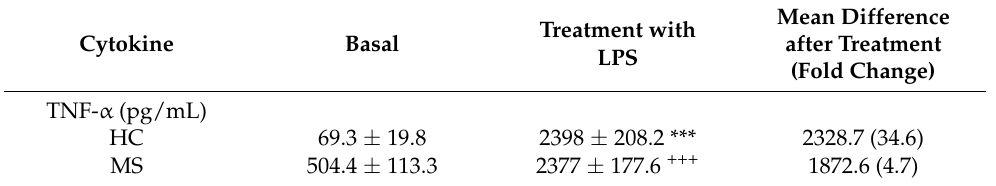
Table 4. Production of TNF- α in the absence and presence of LPS in PBMCs from HC cases and pwMS.